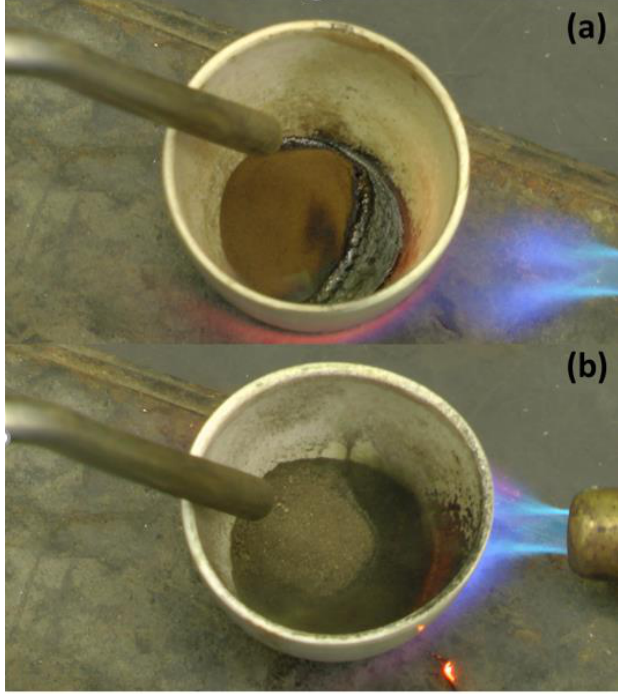
Figure 1. Crucible test of ( a ) lignin and ( b ) magnesium hydroxide / lignin showing the contrast between a material that swells and forms a hard, shiny skin, and one that does not.